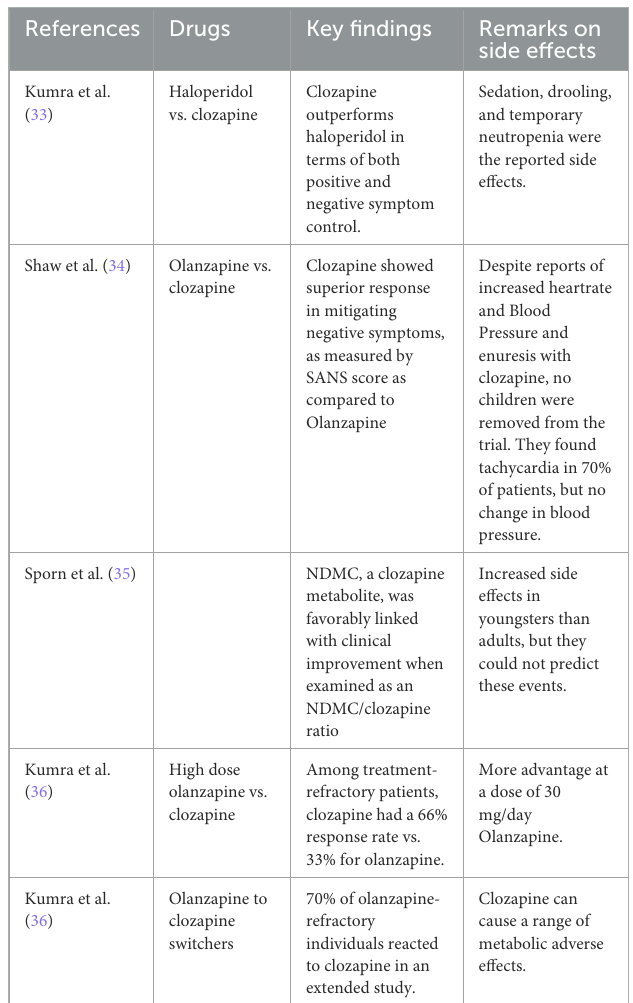
TABLE 2 Review of evidence of clozapine use in childhood